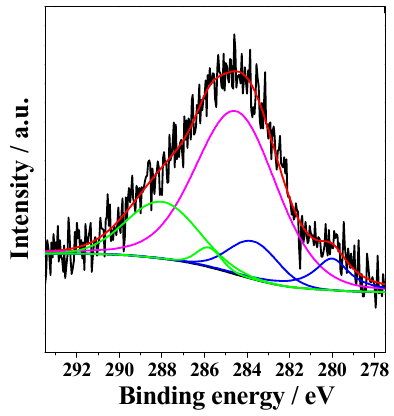
Figure 15. XPS of Ru3d for used Ru/Al 2 O 3 ‐ NaBH 4 catalyst under the He gas cooling (black line: original data line; red line: fitting curve; pink line: the characteristic peak of C; blue line: the characteristic peak of metallic Ru; green line: the characteristic peak of Ru 4+ ).